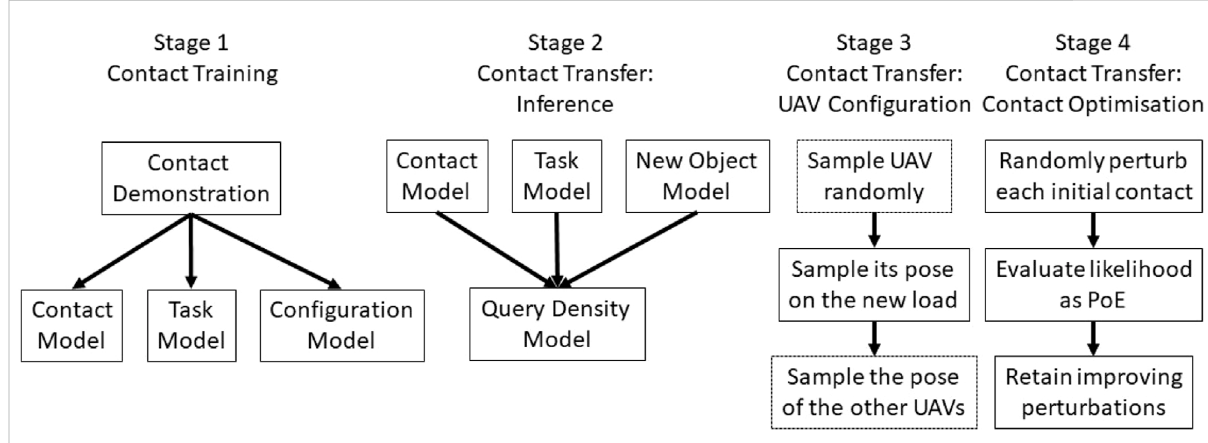
FIGURE 2 Full pipeline of our method. Stage 1 represents the training of the models. From one single example we extrapolate the three models as probability density functions. Inferring the contact on a new load is decomposed in the three phases: Stage 2 samples similar local contacts on the newobject;Stage3samplesafeasiblecon fi gurationfortheUAV(s);andStage4optimisesthecontactsandcon fi gurationsforabettersolution,ifany. The baseline approach uses the same pipeline but without the task model. For a single UAV Stage 3 ’ s dotted blocks are disregarded.